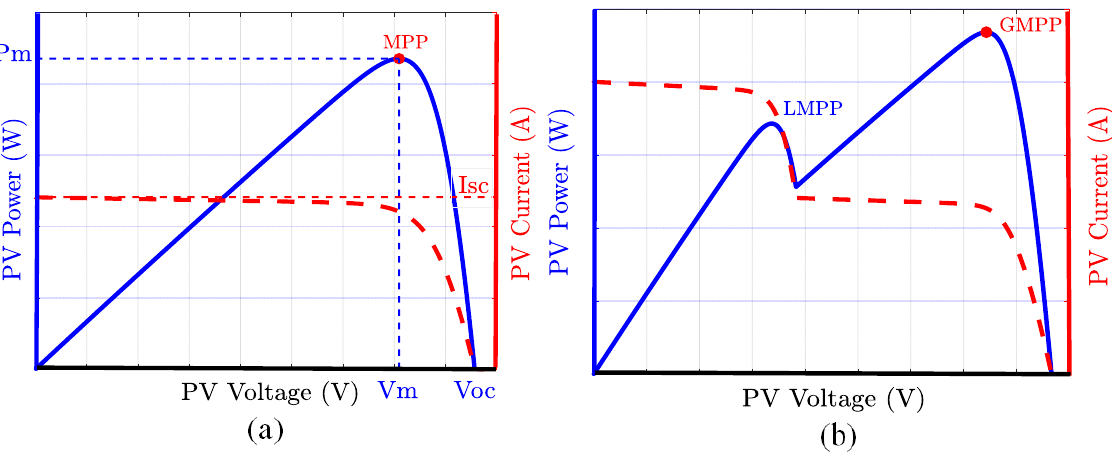
Figure 1. The PV string’s P-V and I-V curves: ( a ) under (UI); ( b ) under (PSC).